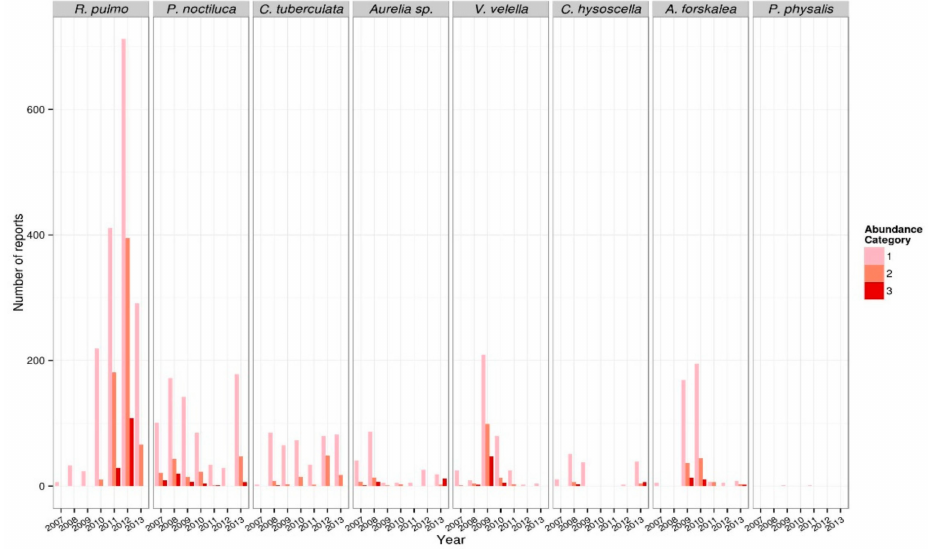
Figure 4. Total number of jellyfish reports from 2007 to 2013 for Spain. Each sector represents a different species, and the color scale represents different abundance categories (darker colors meaning higher